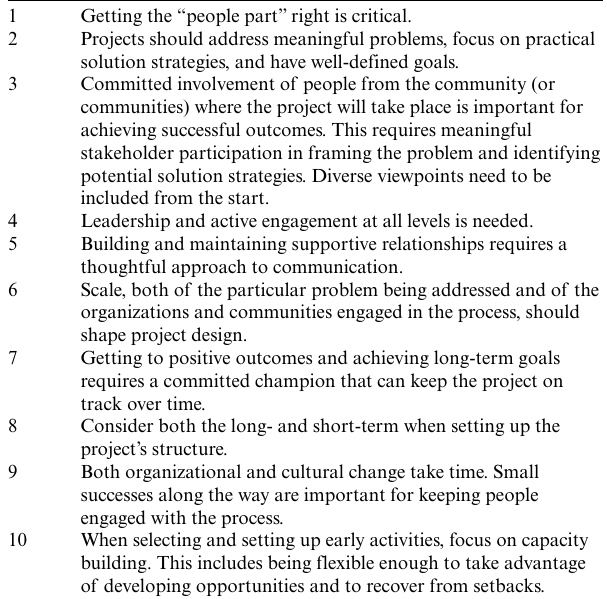
Table 3 . Themes identified from the interviewees’ recommendations, listed in order of